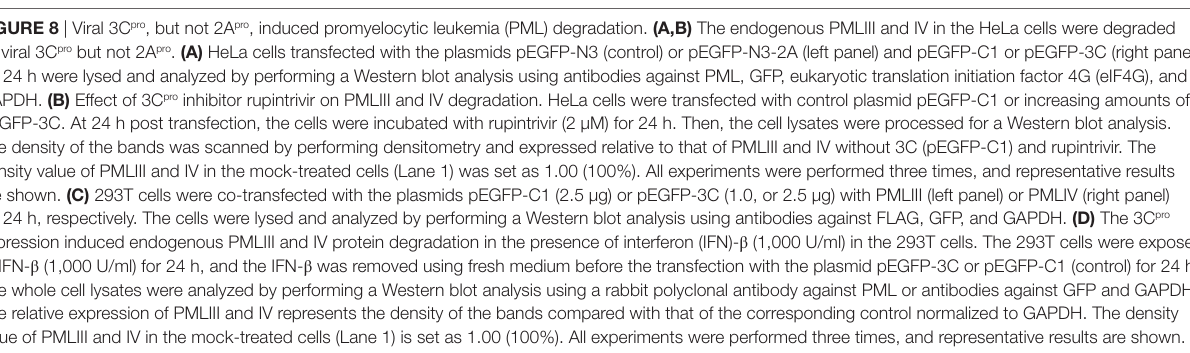
FigUre 8 | Viral 3C pro , but not 2A pro , induced promyelocytic leukemia (PML) degradation. (a,B) The endogenous PMLIII and IV in the HeLa cells were degraded by viral 3C pro but not 2A pro . (a) HeLa cells transfected with the plasmids pEGFP-N3 (control) or pEGFP-N3-2A (left panel) and pEGFP-C1 or pEGFP-3C (right panel) for 24 h were lysed and analyzed by performing a Western blot analysis using antibodies against PML, GFP, eukaryotic translation initiation factor 4G (eIF4G), and GAPDH. (B) Effect of 3C pro inhibitor rupintrivir on PMLIII and IV degradation. HeLa cells were transfected with control plasmid pEGFP-C1 or increasing amounts of pEGFP-3C. At 24 h post transfection, the cells were incubated with rupintrivir (2 µM) for 24 h. Then, the cell lysates were processed for a Western blot analysis. The density of the bands was scanned by performing densitometry and expressed relative to that of PMLIII and IV without 3C (pEGFP-C1) and rupintrivir. The density value of PMLIII and IV in the mock-treated cells (Lane 1) was set as 1.00 (100%). All experiments were performed three times, and representative results are shown. (c) 293T cells were co-transfected with the plasmids pEGFP-C1 (2.5 µg) or pEGFP-3C (1.0, or 2.5 µg) with PMLIII (left panel) or PMLIV (right panel) for 24 h, respectively. The cells were lysed and analyzed by performing a Western blot analysis using antibodies against FLAG, GFP, and GAPDH. (D) The 3C pro expression induced endogenous PMLIII and IV protein degradation in the presence of interferon (IFN)- β (1,000 U/ml) in the 293T cells. The 293T cells were exposed to IFN- β (1,000 U/ml) for 24 h, and the IFN- β was removed using fresh medium before the transfection with the plasmid pEGFP-3C or pEGFP-C1 (control) for 24 h. The whole cell lysates were analyzed by performing a Western blot analysis using a rabbit polyclonal antibody against PML or antibodies against GFP and GAPDH. The relative expression of PMLIII and IV represents the density of the bands compared with that of the corresponding control normalized to GAPDH. The density value of PMLIII and IV in the mock-treated cells (Lane 1) is set as 1.00 (100%). All experiments were performed three times, and representative results are